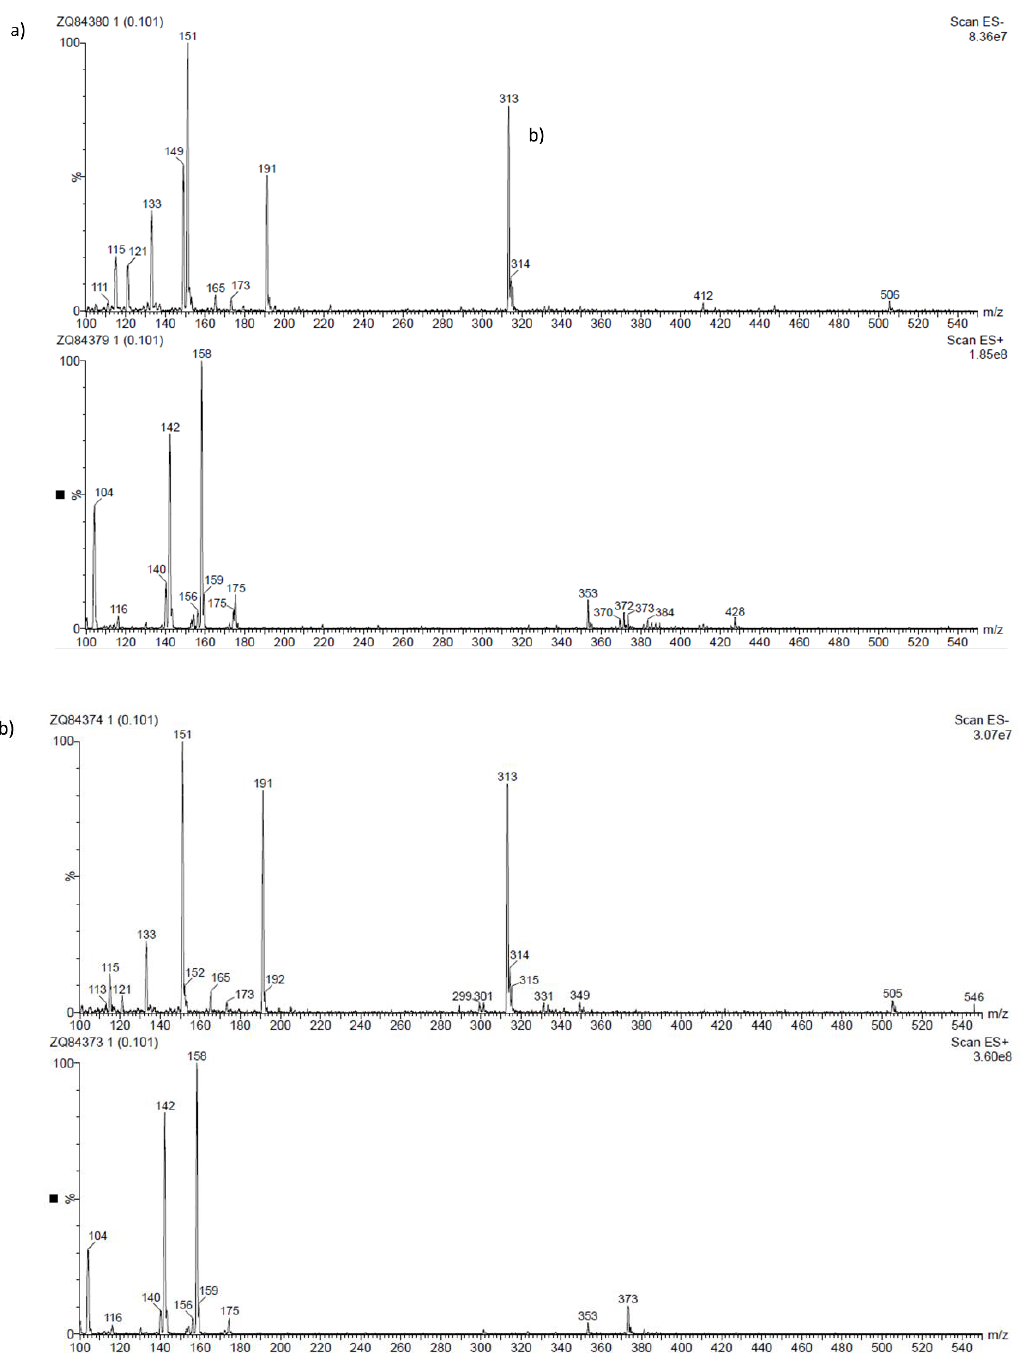
Figure 4. ESI-MS spectra of extract from European Spruce, ( a ) water extract, ( b ) methanol.